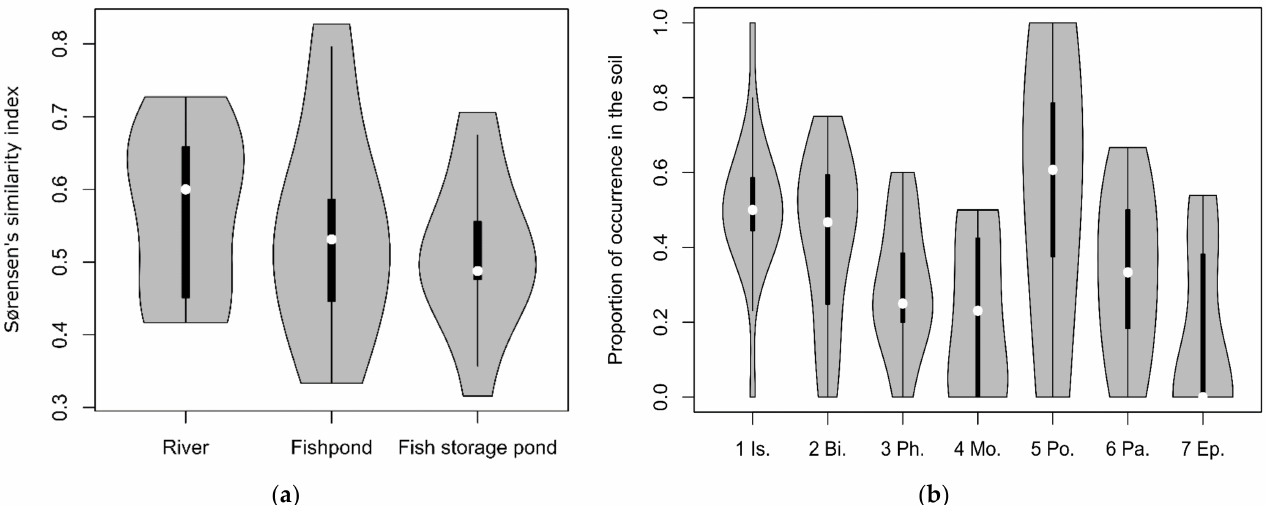
Figure 3. ( a ) Violin plots of Sørensen’s similarity index showing the similarity in species composition between the soil seed bank and the above-ground vegetation (relev é ) for three habitat types: river ( n = 11), fishpond ( n = 10), and fish storage pond ( n = 9). ( b ) Violin plots showing the proportion of occurrence in the soil of the species of seven groups according to phytosociological classes: (1) Isoëto-Nanojuncetea and Crypsietea ( n = 17), (2) Bidentetea ( n = 18), (3) Phragmito- Magnocaricetea and Scheuchzerio-Caricetea ( n = 17), (4) Molinio-Arrhenatheretea and other grassland classes ( n = 15), (5) Potamogetonetea and Lemnetea ( n = 4), (6) Papaveretea and other classes of annual ruderal vegetation ( n = 11), and (7) Epilobietea and other classes of perennial ruderal vegetation ( n =